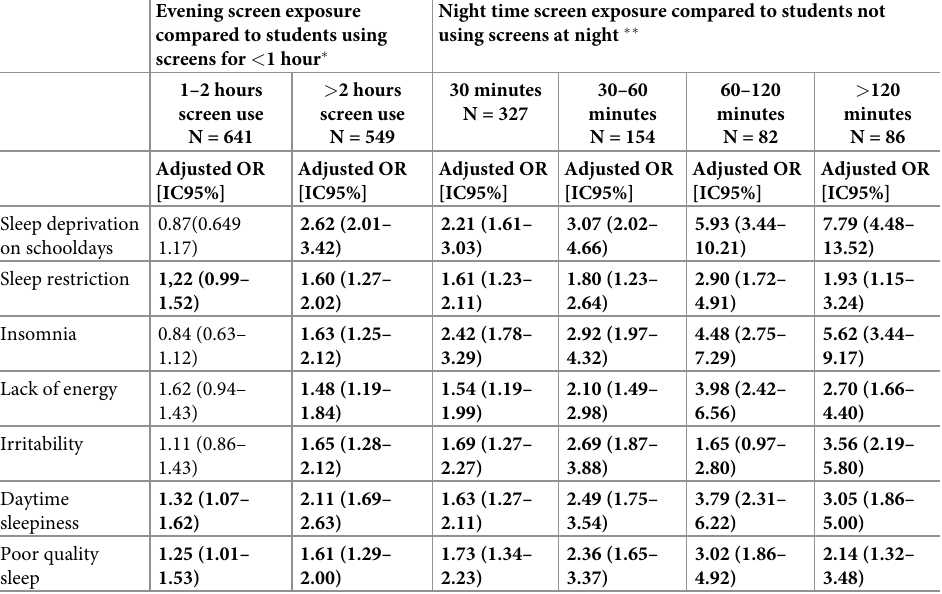
Table 5. The association between the duration of screen exposure during the evening and at night on sleep and daytime function adjusted for age, sex and sociodemographic class adjusted for screen possession and presence of a screen in the bedroom (adjusted OR only).